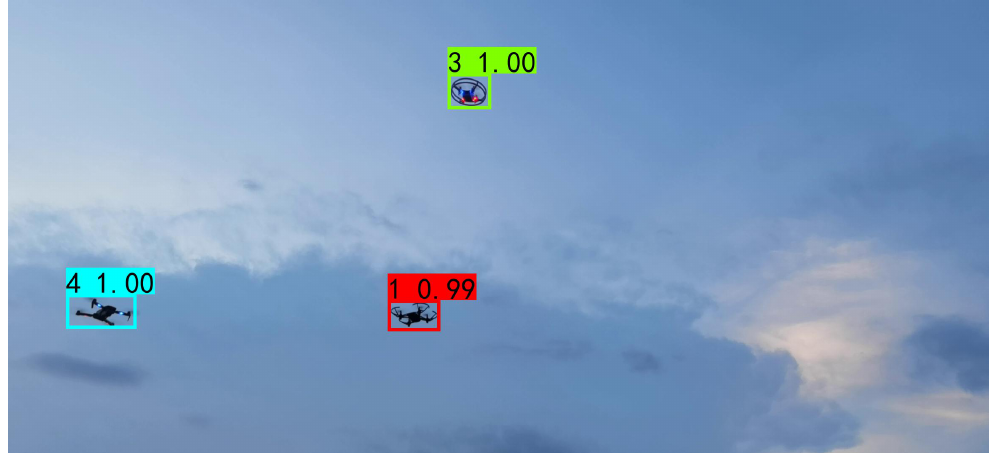
Figure 15. Visualization detection results of the lightweight and accurate UAV detection method based on